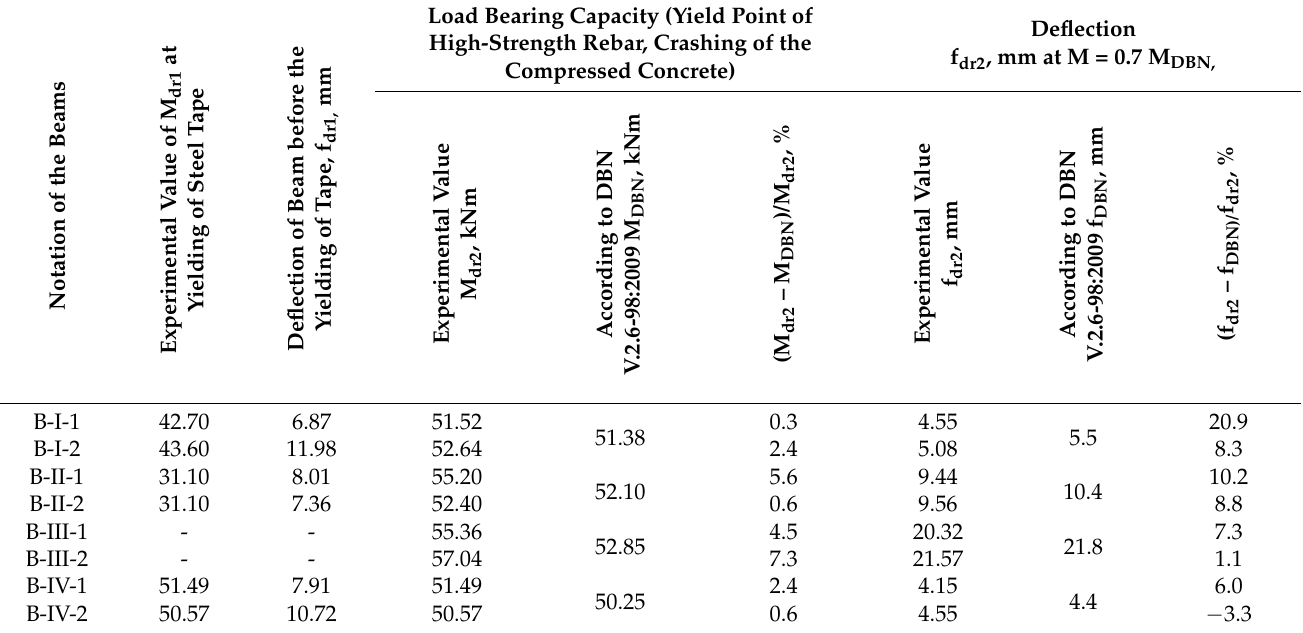
Table 6. Experimental results for steel–concrete beams with combined